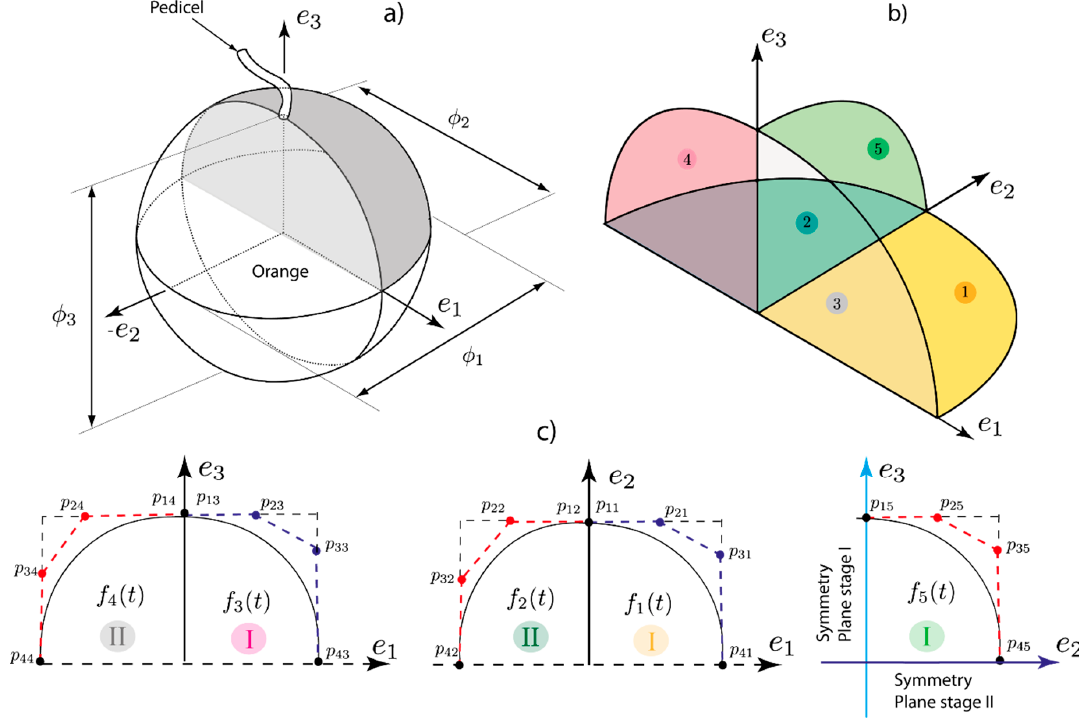
Figure 1. ( a ) Simplified geometry of Valencia orange–peduncle. ( b ) Principal geometric planes that define the topology of the Valencia orange. ( c ) Bézier’s curves on the five principal geometric planes. It was assumed that one-fourth of the fruit was limited by five sets of functions established at the planes , as observed in Figure 1b,c. Each set of f t represent Bézier cubic curves that were constructed with the points of control 𝑃 (cid:2869)(cid:3036) , functions ( ) i 𝑃 𝑃 𝑃 (cid:2870)(cid:3036) , (cid:2871)(cid:3036) , and (cid:2872)(cid:3036) , established in each plane . Knowing that a Bézier cubic curve [24] is represented commonly as